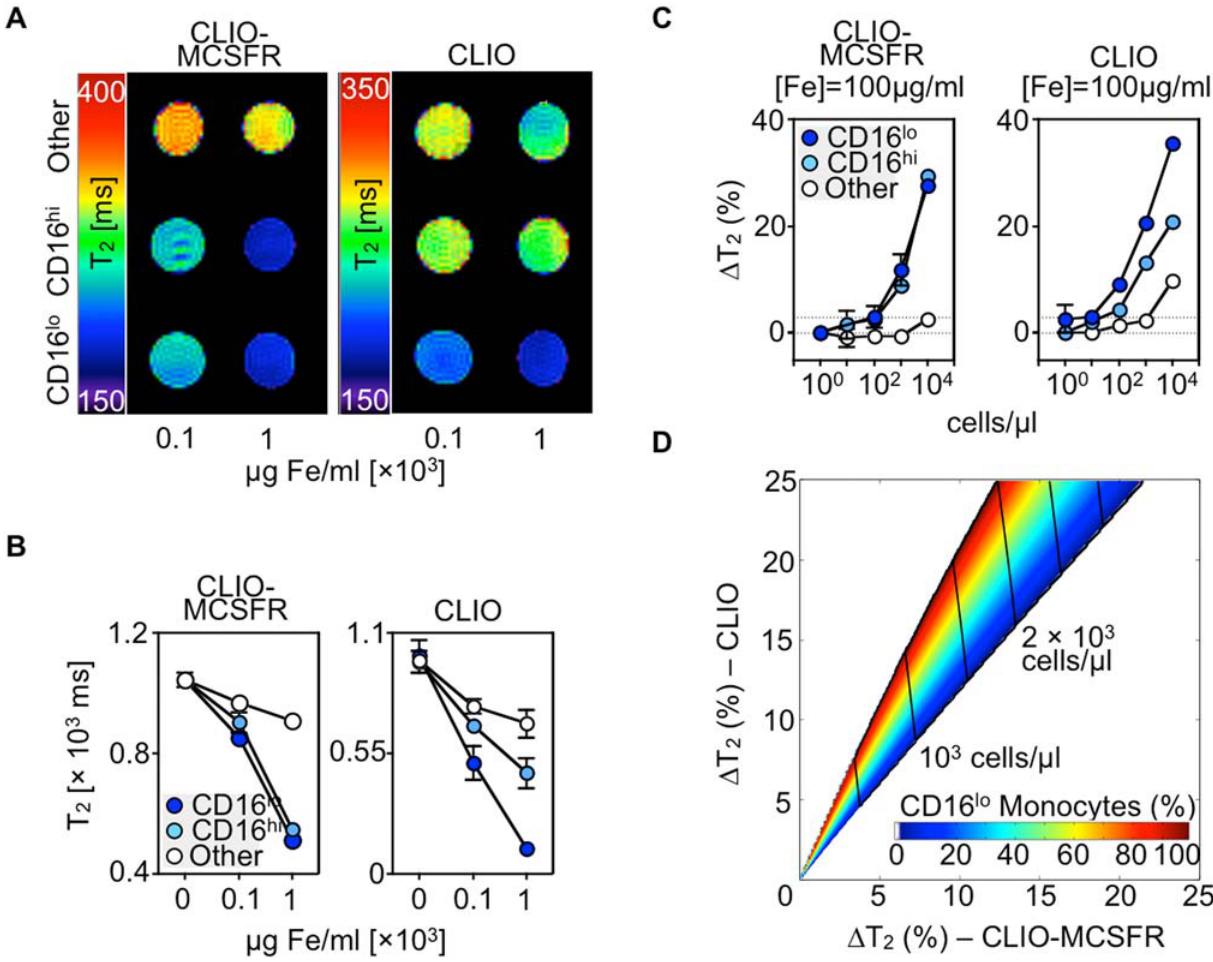
Figure 3. Ex-vivo Nuclear Magnetic Resonance generates an enumerative mathematical model for monocyte subsets. A. Representative NIH-color coded map generated from T 2 -weighted Magnetic Resonance Imaging. Data show equal number of CD16 lo , CD16 hi monocytes and other leukocytes labeled with two CLIO-MCSFR (left panel) and CLIO (right panel) concentrations. B. T 2 measurements detected with a conventional benchtop-relaxometer. Data show equal number of CD16 lo , CD16 hi monocytes and other leukocytes labeled with two CLIO-MCSFR (left panel) and CLIO (right panel) concentrations. N=3–5. Mean 6 SEM. C. T 2 changes detected with a diagnostic magnetic resonance (DMR) chip. Data show increasing number of CD16 lo , CD16 hi monocytes and other leukocytes labeled with one CLIO-MCSFR (left panel) and CLIO (right panel) concentration. N=3. Mean 6 SEM. D. Two-dimensional T 2 map derived from data in C to simultaneously enumerate total monocyte numbers and subset proportions. Model combines T 2 changes for CLIO-MCSFR (x-axis) and CLIO (y-axis). Changes in predicted monocyte number are demarcated with vertical lines while the rainbow region defines monocyte subset fluctuations.